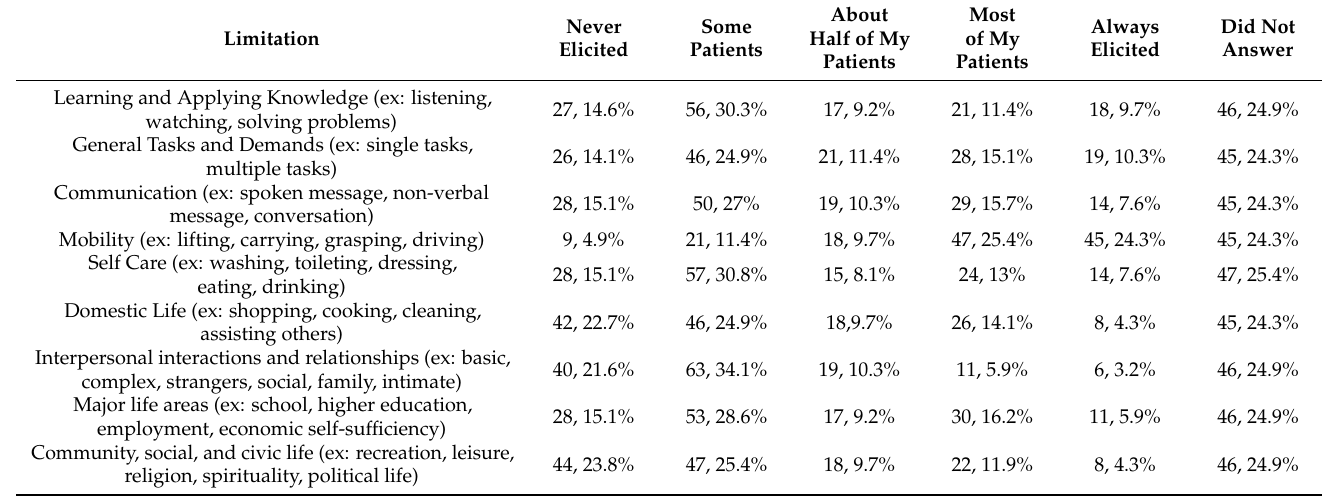
Table 7. Participant Report of Screening in Clinical Practice for Activity Limitations and Participation ( n ,